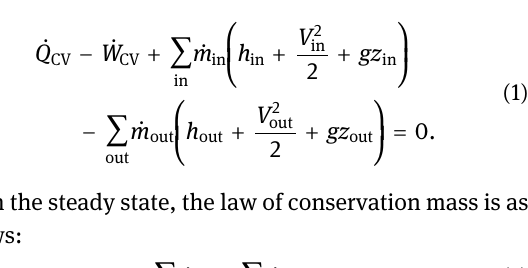
Figure 4: Diagram of an ab cogeneration